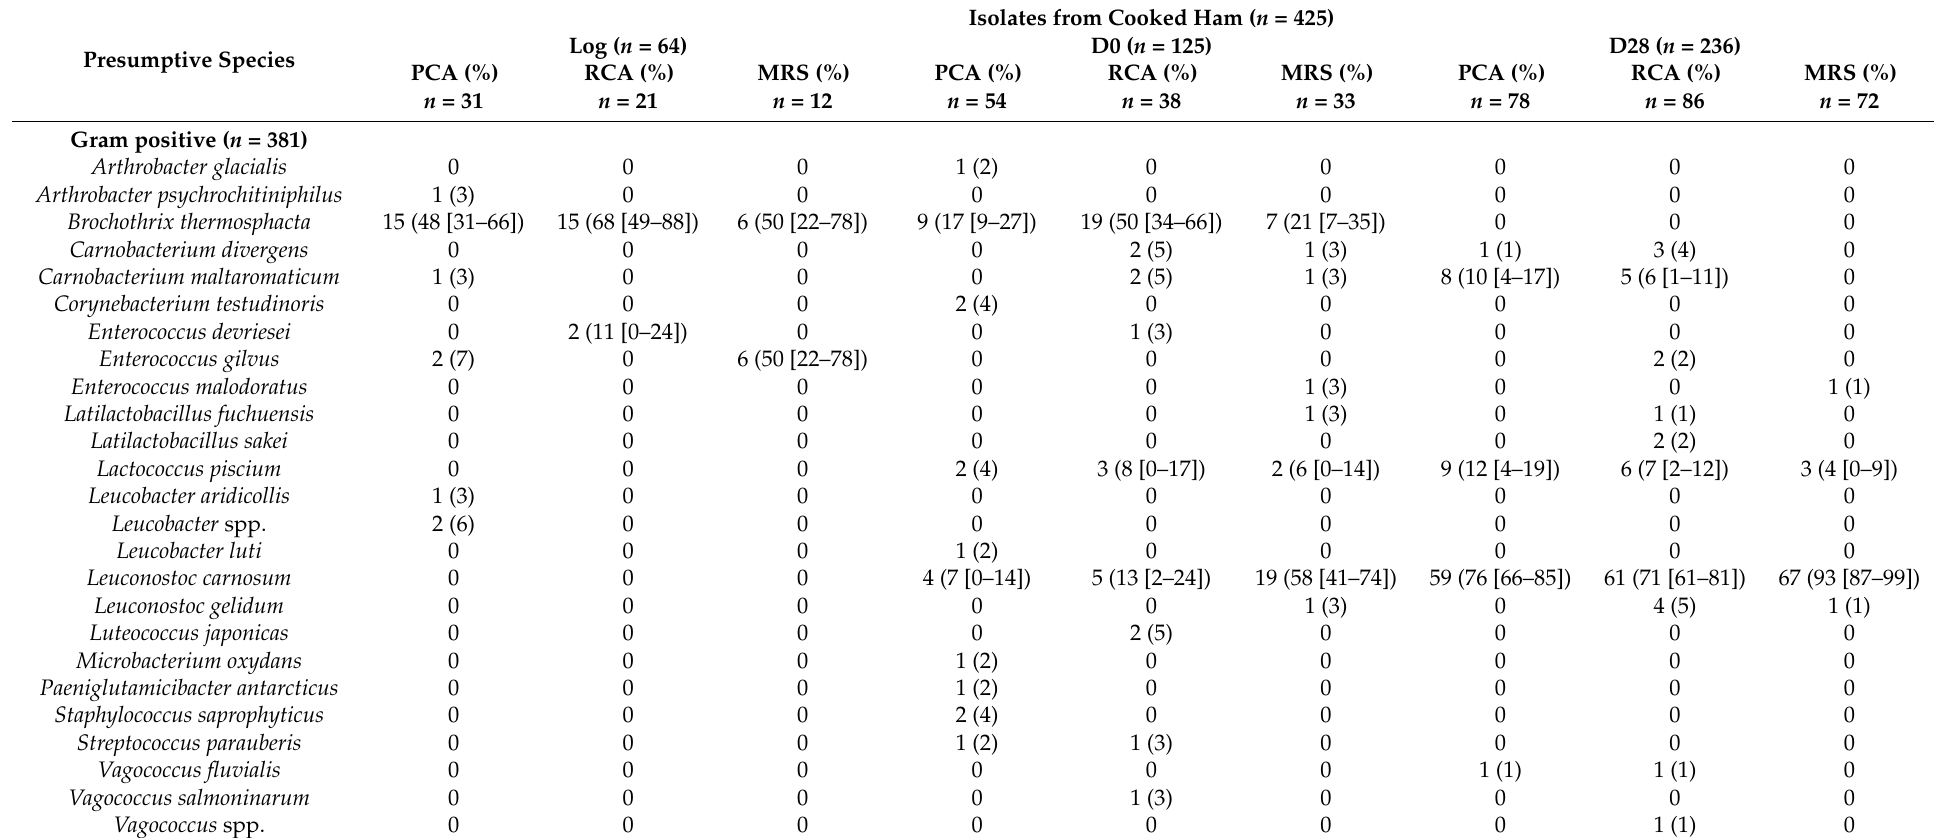
Table 2. Genus and presumptive species identity of isolates from PCA, RCA and MRS agar media for the cooked ham samples. Percentages of isolates were calculated on the total of identified isolates per medium. Confidence intervals for percentages of number of identified isolates are calculated for the three most abundant (if three were present) identifications per sampling moment from PCA, RCA and MRS agar media and are presented between square